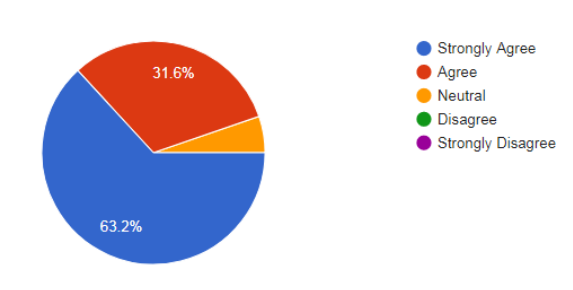
Figure 7: Were the faculty were acquainted about training topics